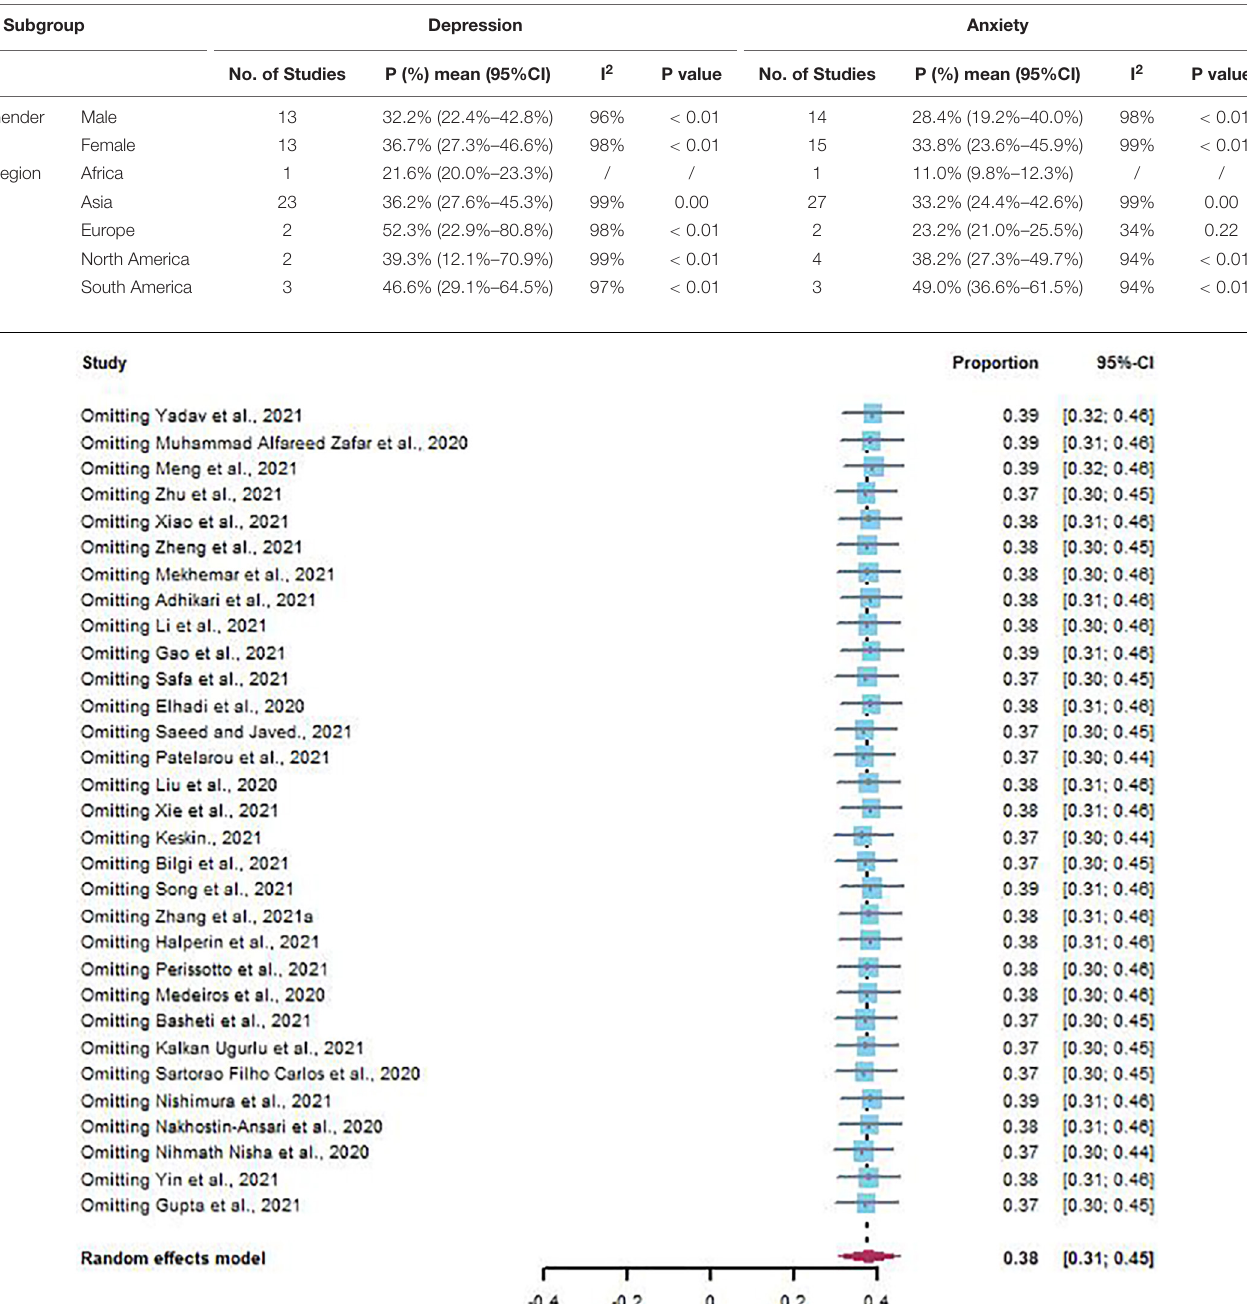
TABLE 3 | Subgroup analysis based on gender and region.